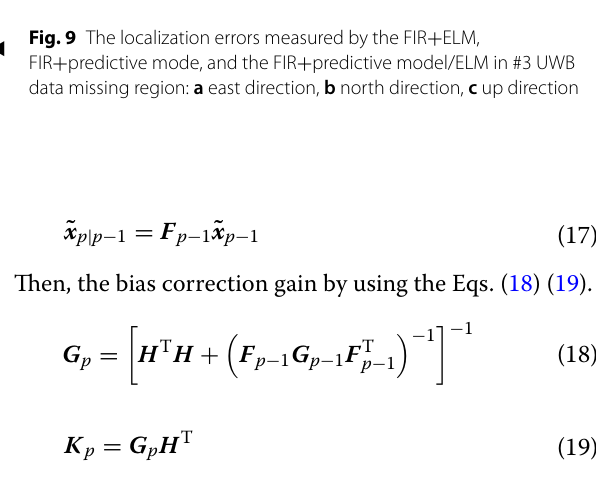
predictive model/ELM in #3 UWB +